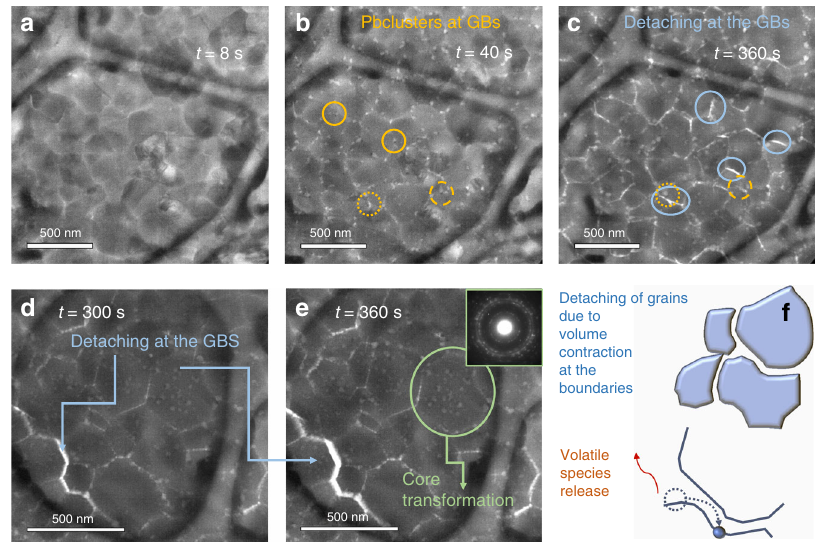
Fig. 7 Time resolved transformation pathway of a 150 nm-thick sublimated MAPbI 3 layer. a – e Plan-view TEM images taken along the labelled timescale. The sequence from ( a – c ) is taken at fi xed sampled area. Images ( d , e ) are taken on another region of the sample and used to highlight the progression of the detachment of a raw of grains. d also shows a change in the inner grain morphology (white objects are empty spaces) to 6H-PbI 2 , as further shown by the EDP in the inset. For each images the acquisition time was 8 s. Electron dose rate was 1 e − /A 2 s. f Schematic on the detaching phenomenon along a row of grains as a consequence of the GBs shrinkage due to MAPbI 3